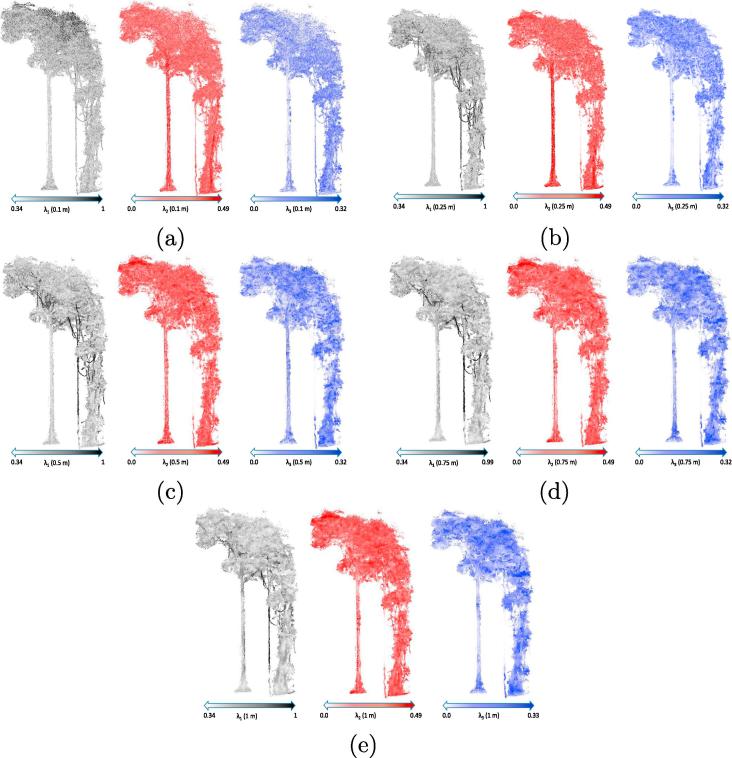
Illustrating the effectiveness of eigen values at multiple scales for classifying lianas in Nouragues (sample from plot NOU_5 in Table 1). The ground truth of the same plot is given in Fig. 3. The color scales at the bottom of each figure indicate the range of λ1,λ2 and λ3 at (a) 0.1 m, (b) 0.25 m, (c) 0.5 m, (d) 0.75 m and (e) 1 m spatial scale from left to rig.ht respectively.